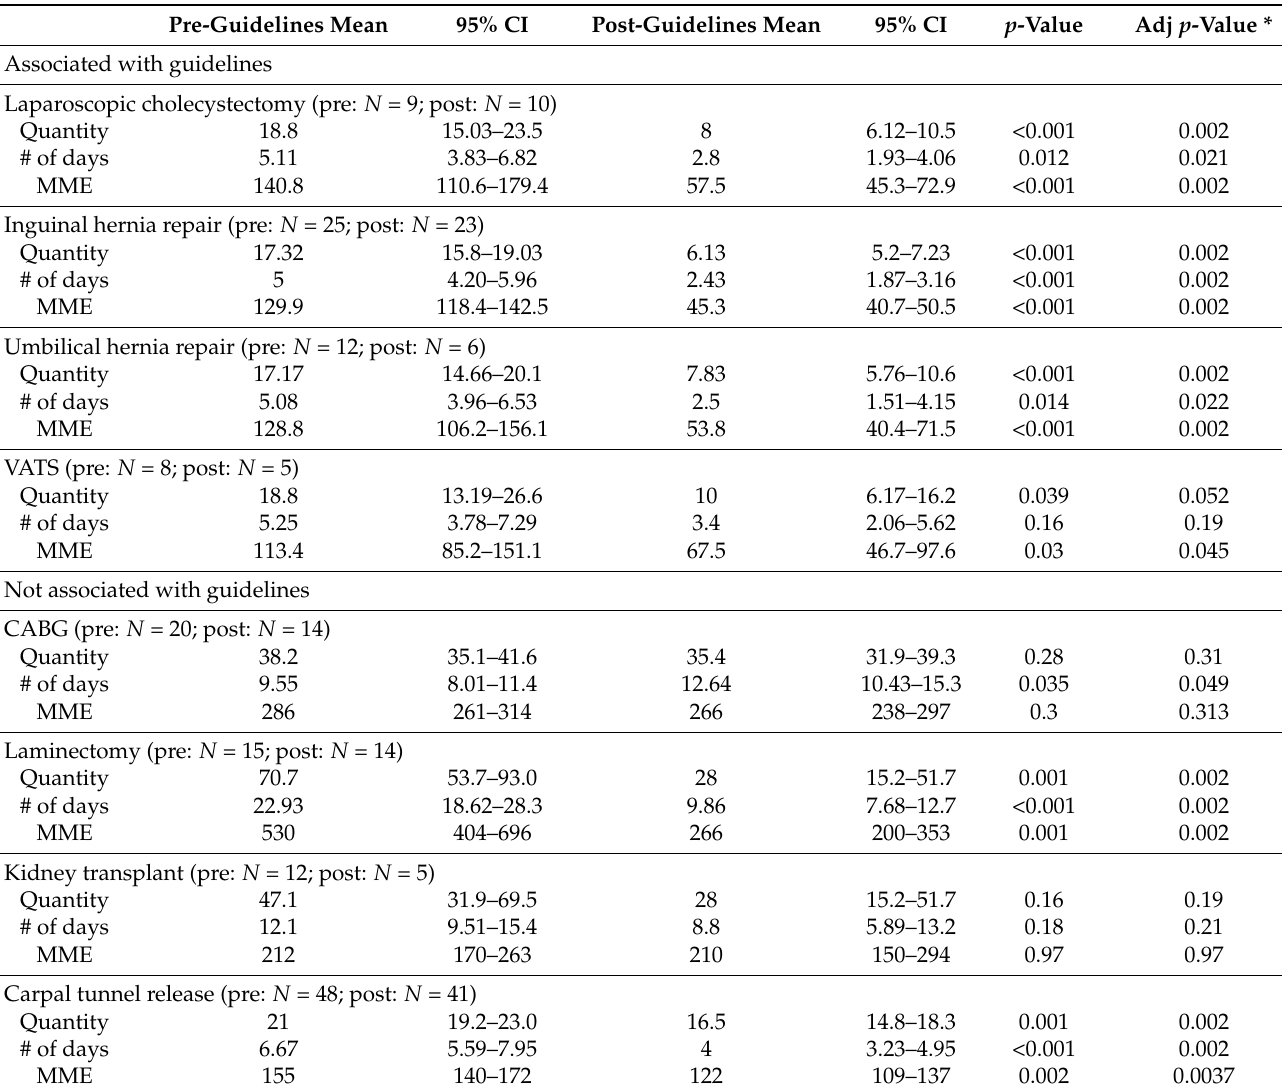
Table 1. Pre- and post- guideline opioid prescribing in procedures with and without associated